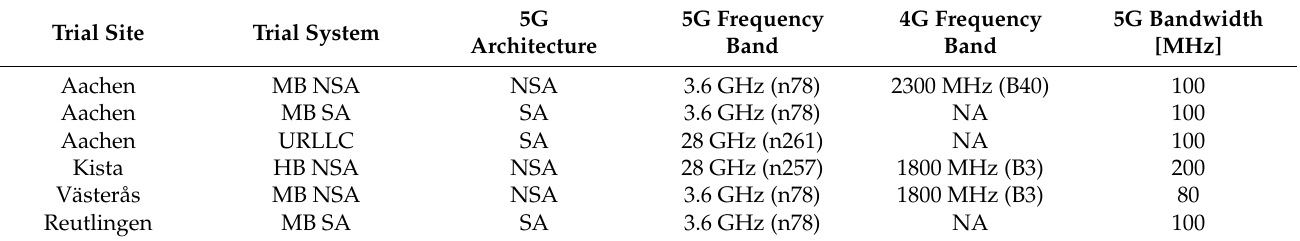
Table 2. 5G-SMART trial system